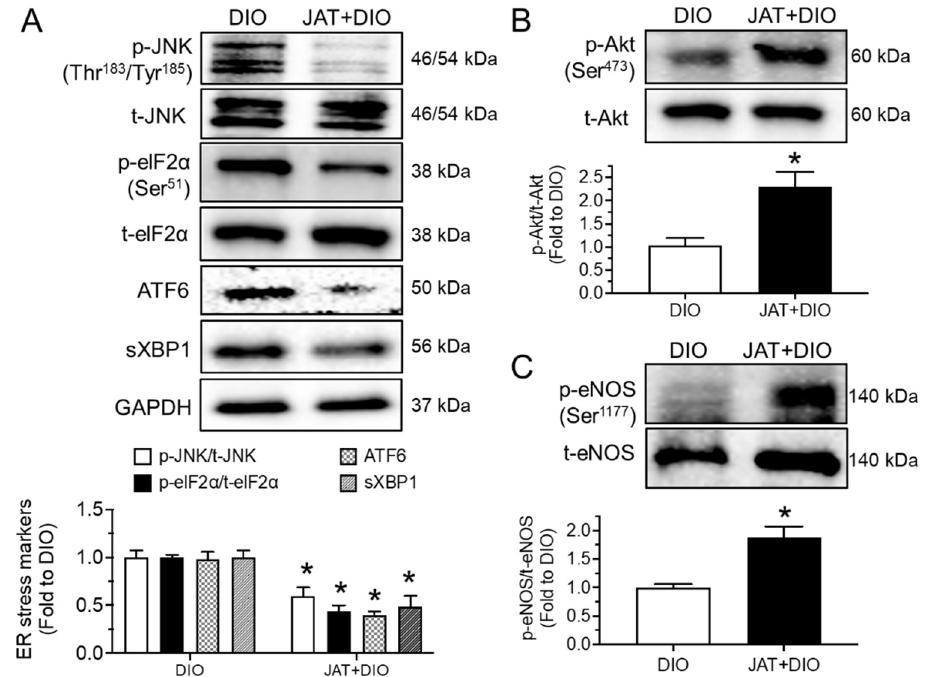
5 of 16 Figure 3. Jatrorrhizine attenuates endoplasmic reticulum (ER) stress and stimulates Akt/eNOS path- way in mouse aortas in hyperglycemic conditions ex vivo. ( A – C ) Western blotting data showing the